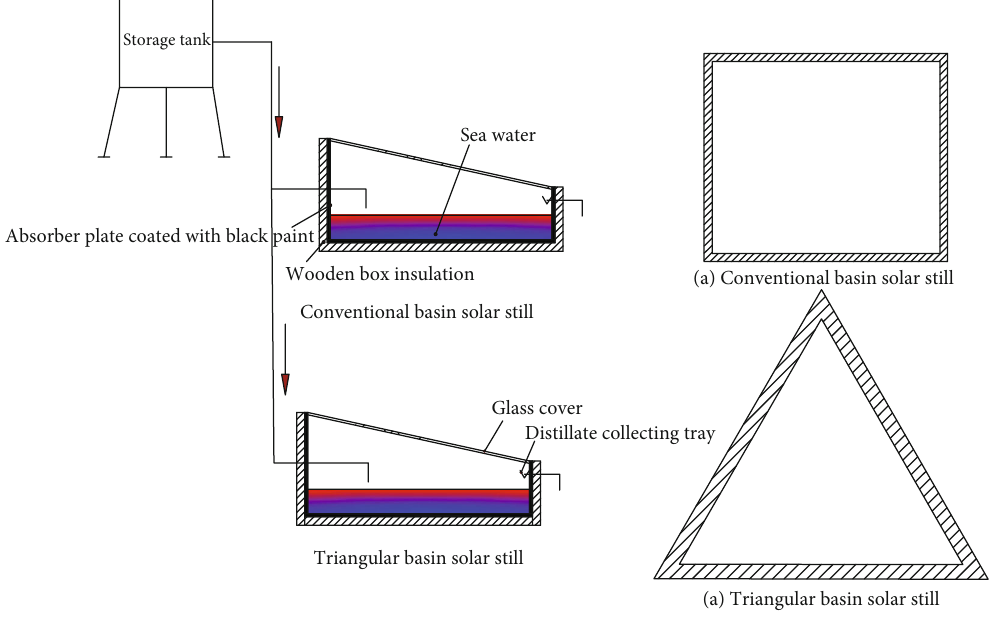
Figure 2: Schematic diagram of conventional and triangular basin solar still. Table 1: Range, accuracy, error, and instruments used in the